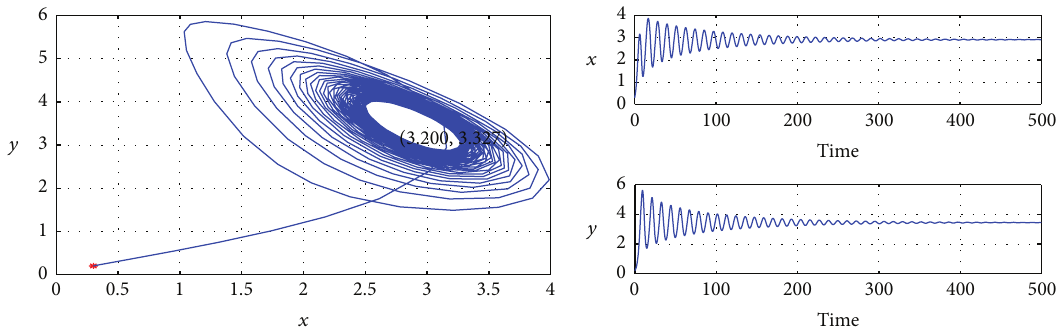
Figure 8: When 𝜏 = 2.7 < 𝜏 0 ≐ 2.8015 , the positive equilibrium 𝐸 ∗ of system (5) is asymptotically stable.